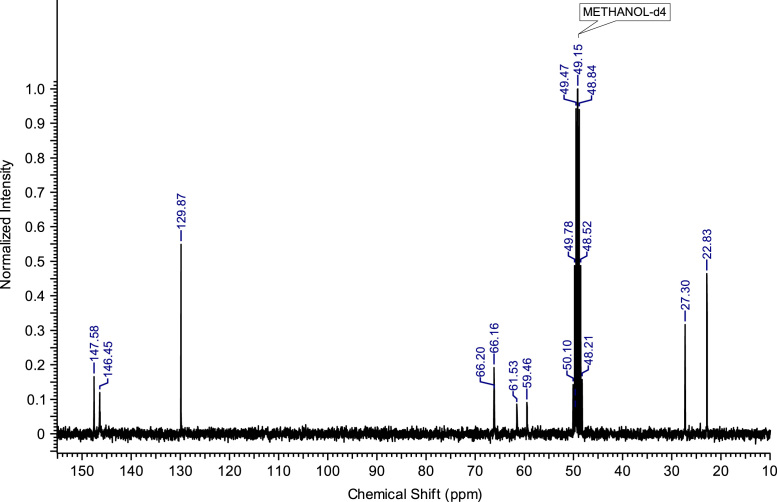
13C NMR spectra of C3(Pyr)(MPyrr)Br2.